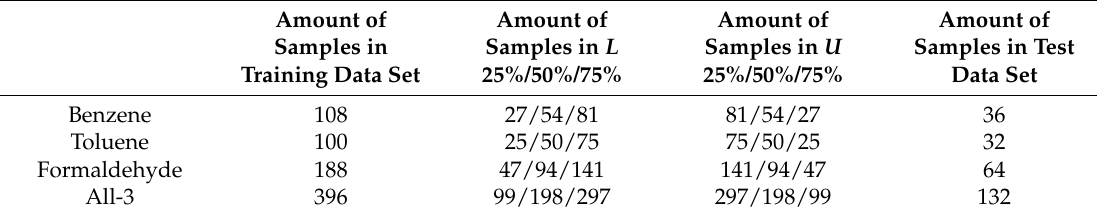
Table 6. Amount of samples in each data set.